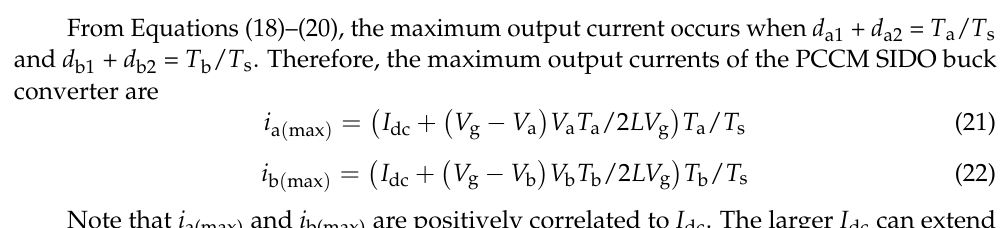
ˆˆ v i ; ( b ) ˆˆ v i a a b b